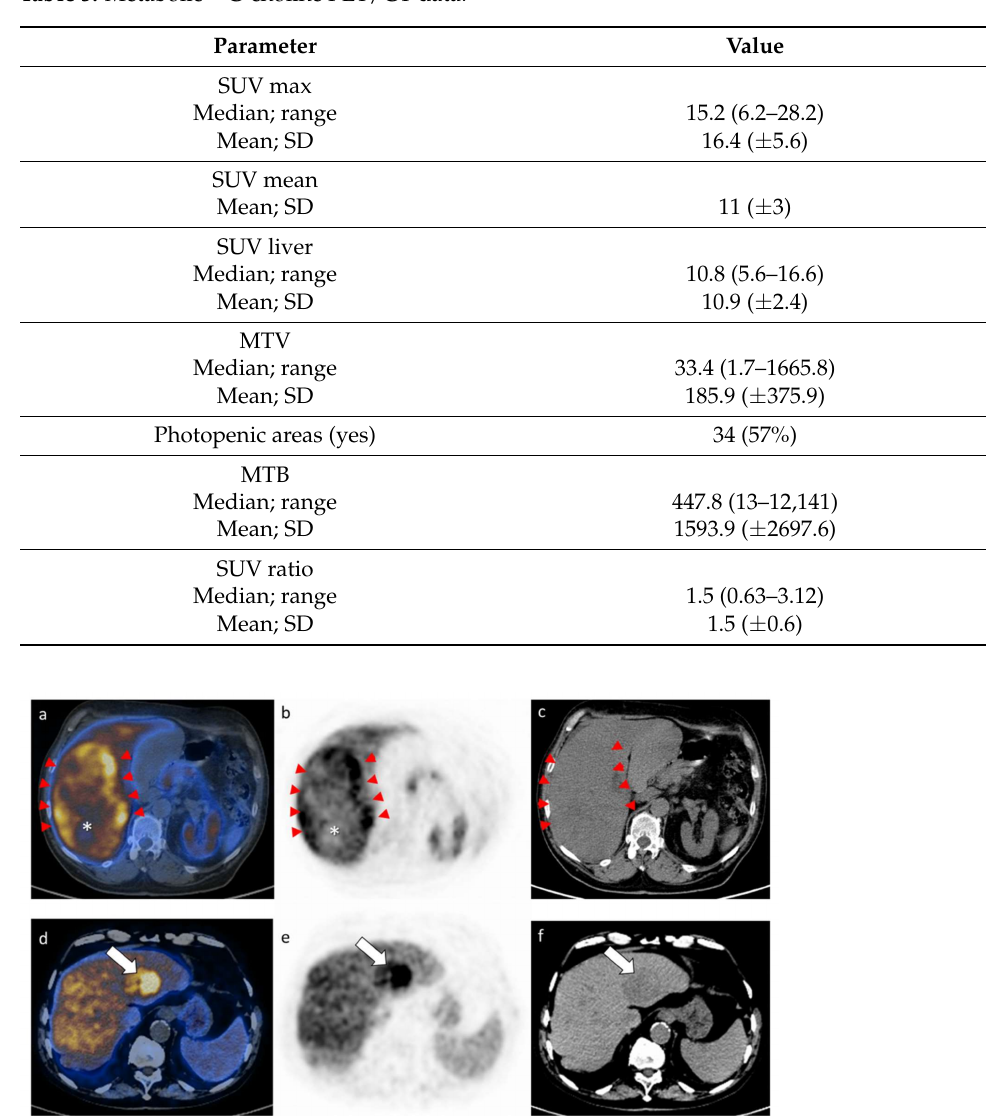
Table 3. Metabolic 11 C-choline PET/CT data.